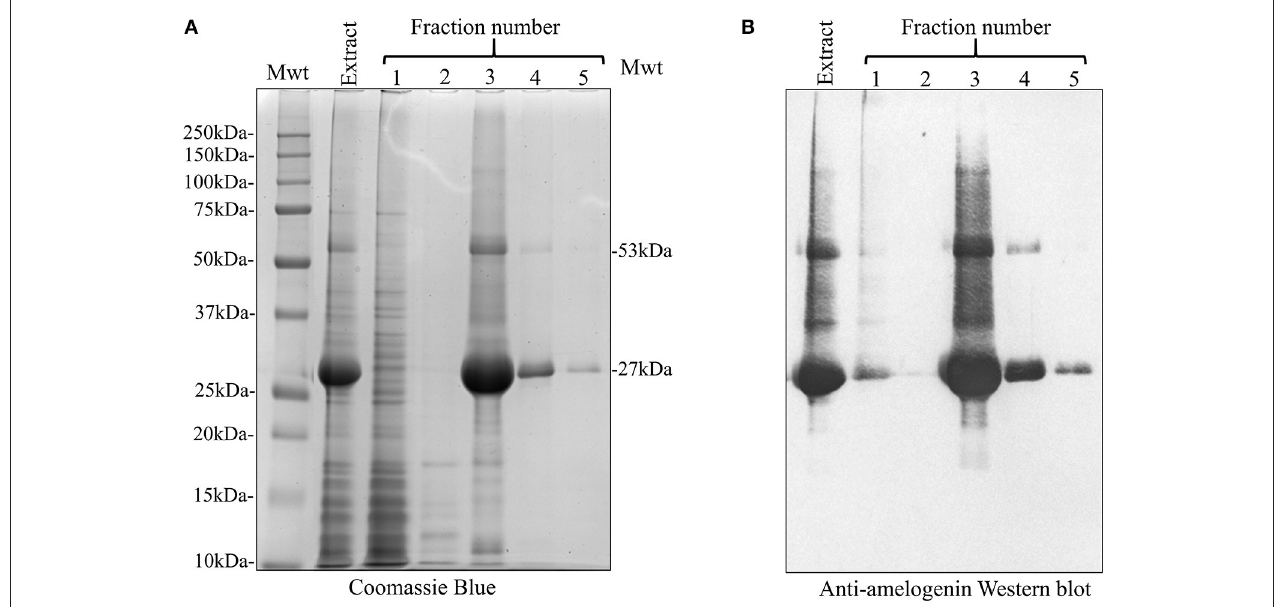
FIGURE 4 | SDS PAGE and anti-amelogenin Western blot analysis of the crude 3% acetic acid E. coli extract and nickel column fractions 1–5. (A) Extraction with 3% acetic acid (Extract) generated an enriched recombinant amelogenin fraction. In particular, bacterial contaminants migrating above 27 kDa were selectively removed (compare with Figure 2 ). Fractions 1–2, corresponding to the column flow-through, contained many of the bacterial proteins contaminating the crude acetic acid extract. Fractions 3–4 contain proteins eluted by 200 mM imidazole. The 27 kDa recombinant protein is further enriched but still contains contaminating proteins.